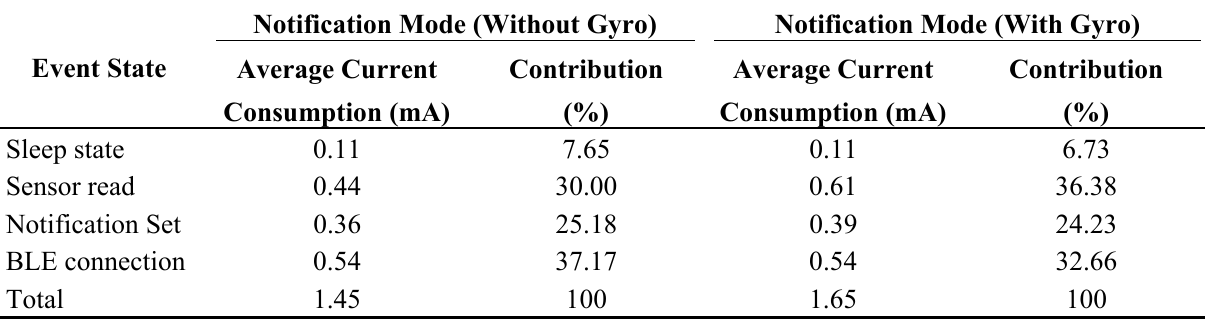
Table 2. Power consumption breakdown in the notification